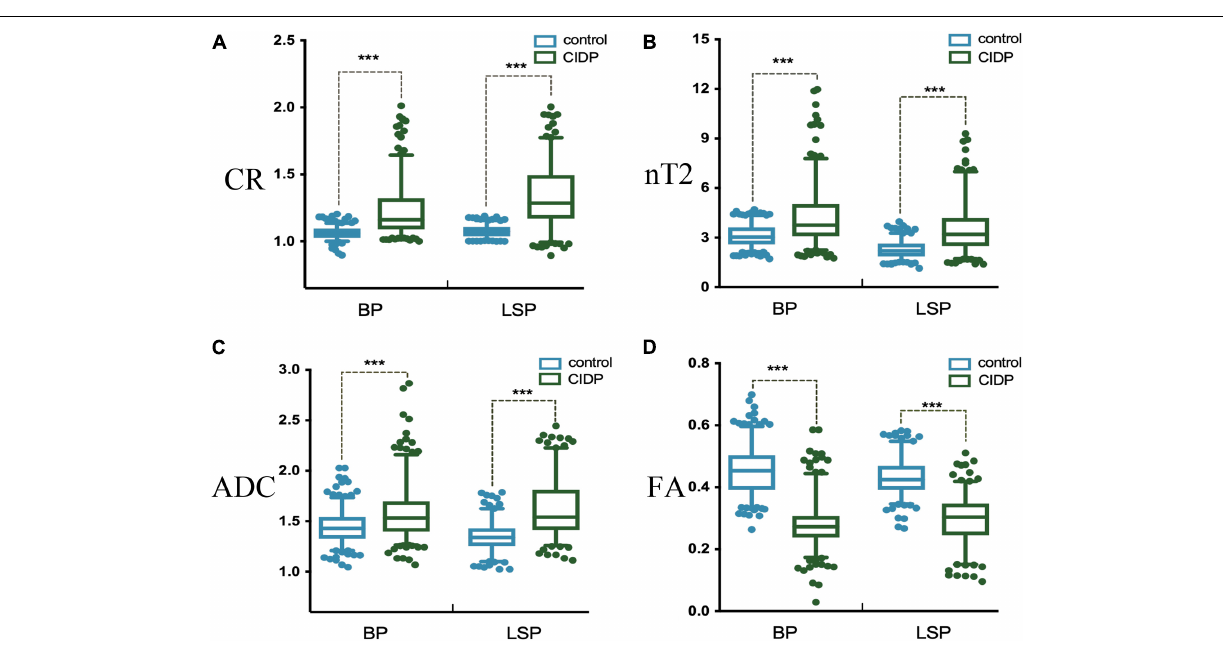
FIGURE 4 | Contrast-enhanced ratio (A) , nerve-to-muscle T2 signal intensity ratio (B) , and apparent diffusion coefficient (C) of the brachial and lumbosacral nerve roots were significantly higher in patients with CIDP than in controls. Fractional anisotropy (D) of the brachial and lumbosacral nerve roots was significantly lower in patients with CIDP than in controls. * p < 0.05; *** p < 0.001; BP, brachial plexus; LSP, lumbosacral